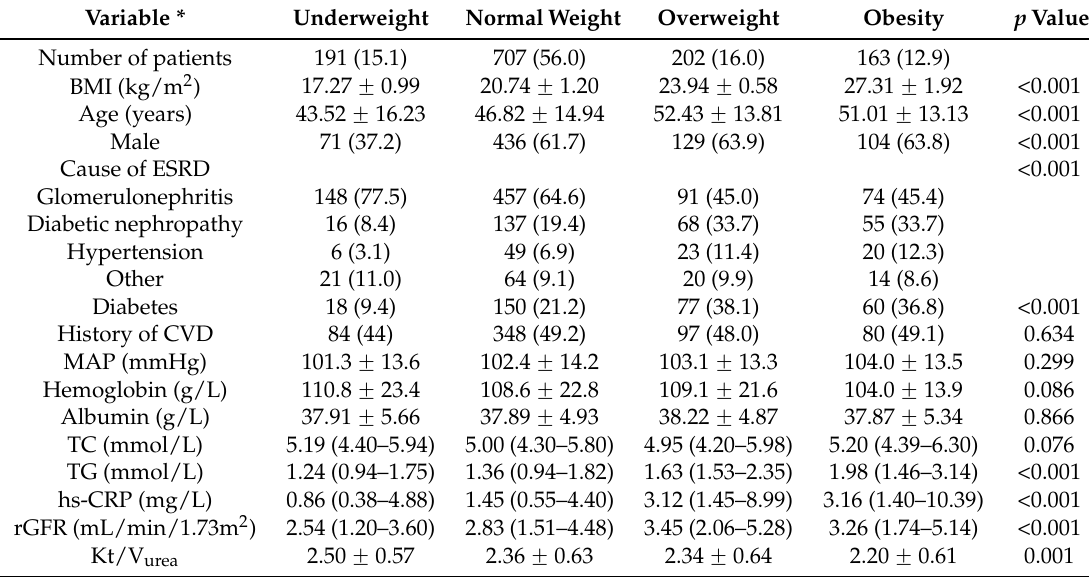
Table 1. Baseline characteristics of the study population by BMI